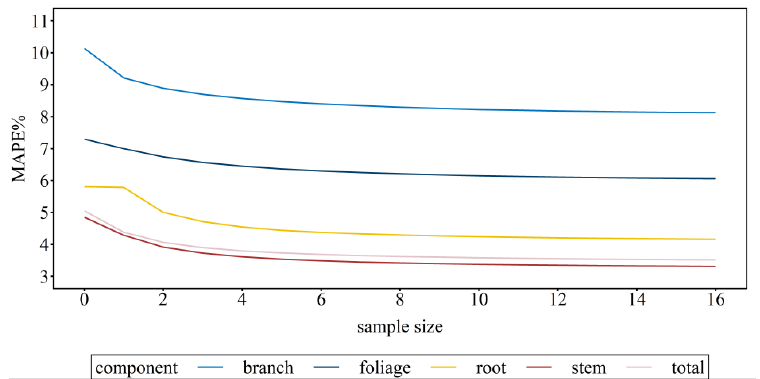
Figure 4. The effect of varying sampling sizes on the prediction of the mixed-effects model in 500 times random